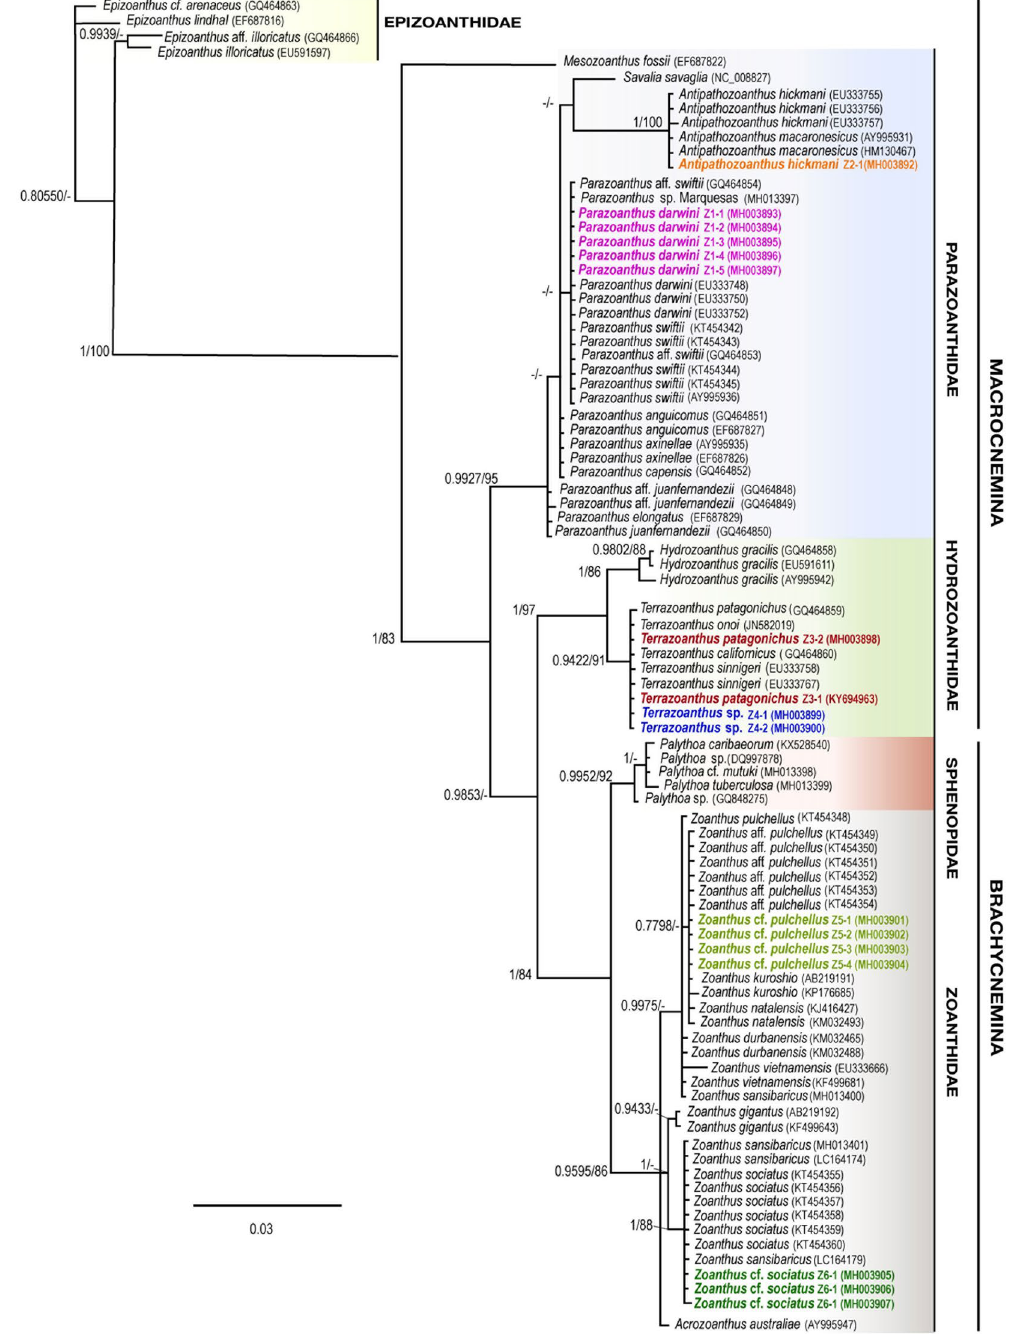
Figure 2. Phylogenetic Bayesian tree obtained from sequences of mitochondrial 16 S ribosomal DNA (mt 16 S rDNA). Bayesian and ML bootstrap support values over 0.75/75% are indicated by the nodes. Values below posterior probabilities of 0.75/75% bootstrap were considered as unresolved. Specimens from this study are indicated in different